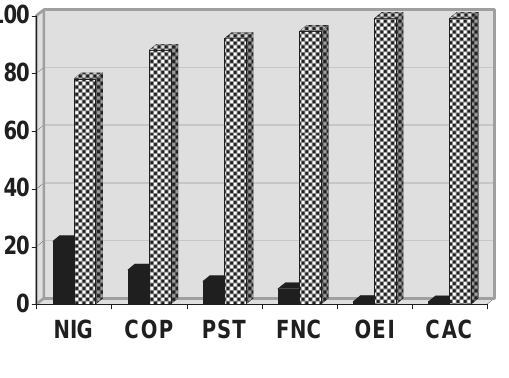
Figure 1: Non-agreement and agreement in third person plural verbs by variety of